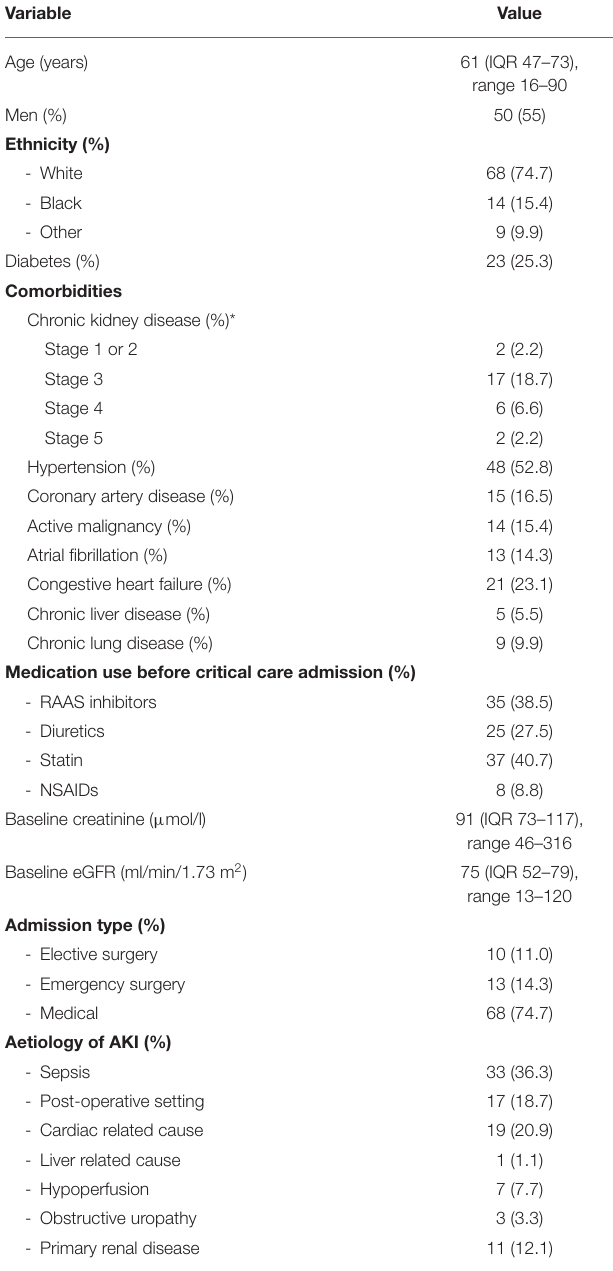
TABLE 1 | Baseline